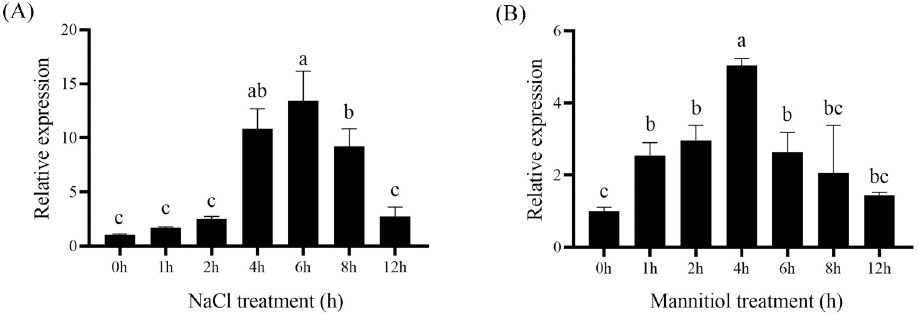
Fig 3. Expression pattern of VvASMT1 in grapevine under salt and osmotic stresses. (A) NaCl, (B)Mannitol. The data were presented as the mean ± SE of three independent experiments. Different letters above the columns indicate significant differences (P < 0.05) according to Duncan’s multiple range test.